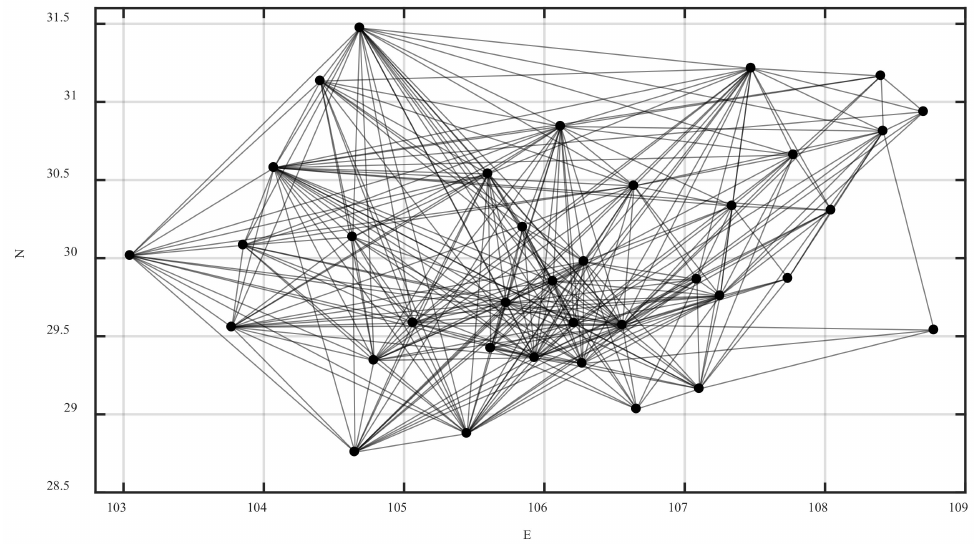
Figure 4. The highway passenger transport network of the Chengdu–Chongqing urban